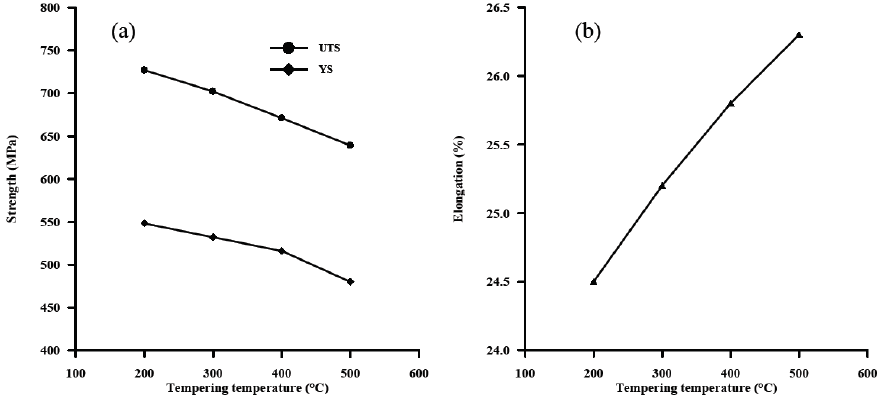
Fig. 4. Change in mechanical properties in the DP X70 steel as a function of tempering